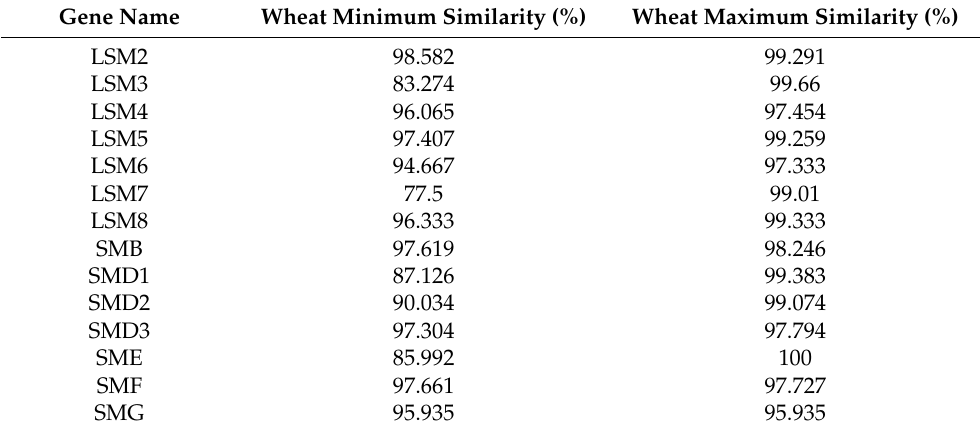
Table 2. The similarity of nucleic acid sequence in CDS region of SSM/SLSM genes in wheat. Gene